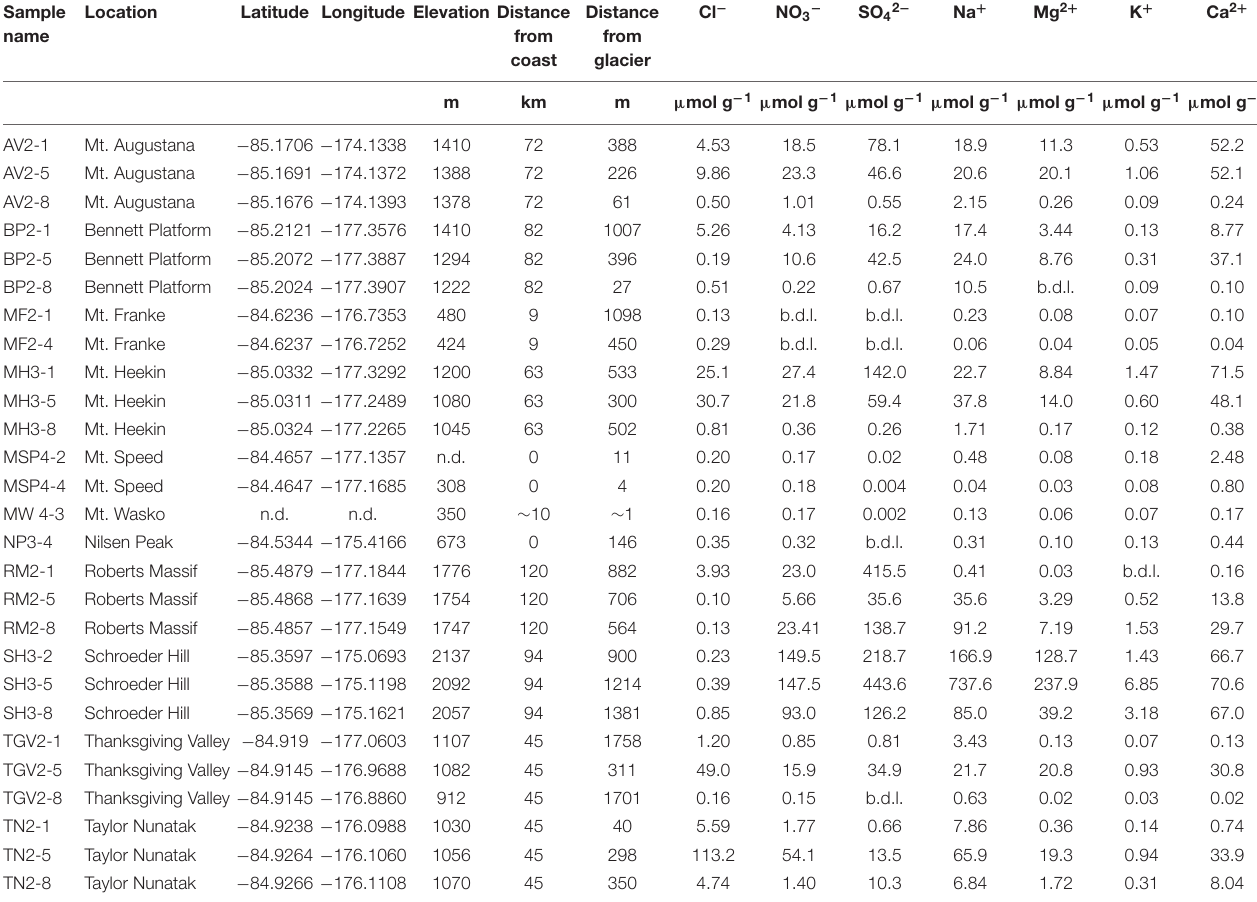
TABLE 1 | Sample geographic information and concentrations of water-soluble ions in soil leaches determined by ion chromatography and nutrient analysis in µ mol g − 1